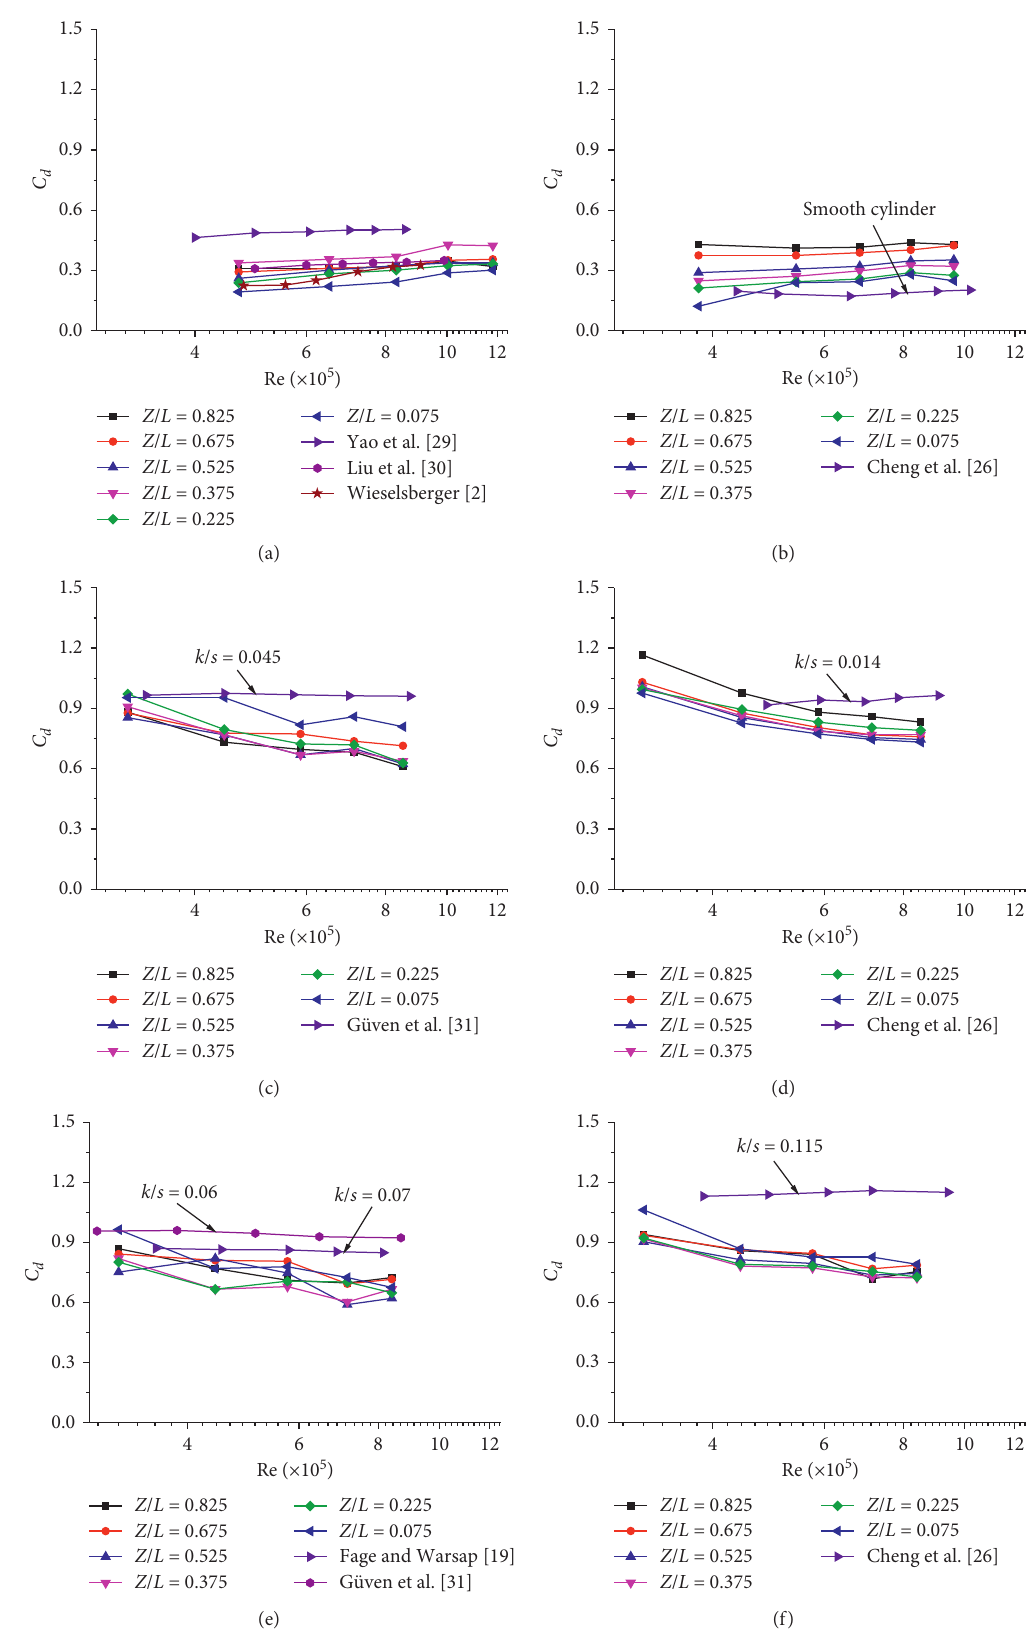
Figure 8: Effect of the Reynolds number on the drag coefficient of each measurement layer. (a, c, e) Uniform flow and (b, d, f) Type A turbulent flow field. (a, b) c � 0, (c, d) c � 0.0386, and (e, f) c �